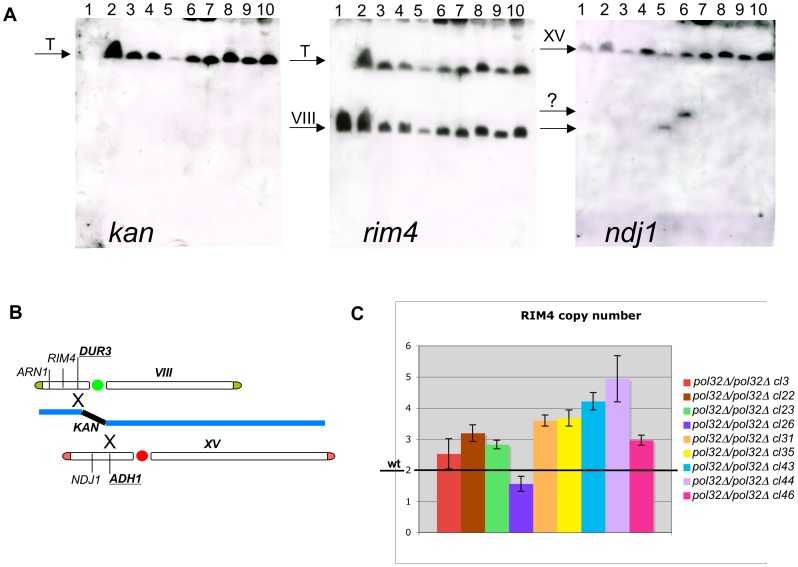
Characterization of nine independent pol32Δ/pol32Δ translocants.A) Southern hybridization of genomic DNA from all the pol32Δ/pol32Δ translocants with probes against kanamycin, rim4 (chromosome VIII) and ndj1 (chromosome XV) loci are shown. Lane 1:wild type San1, 2: pol32Δ/pol32Δcl3, 3: pol32Δ/pol32Δcl22, 4: pol32Δ/pol32Δcl23, 5: pol32Δ/pol32Δcl26, 6 pol32Δ/pol32Δcl31, 7: pol32Δ/pol32Δcl35, 8 pol32Δ/pol32Δcl43, 9 pol32Δ/pol32Δcl44, 10: pol32Δ/pol32Δcl46. T indicates the band of the translocated chromosome. The question mark indicates unknown bands coming from a rearrangement of the left part of chromosome XV on the membrane hybridized with ndj1 B) Scheme of the location of the probes used with respect to the breakpoints (underlined) C) The RIM4 copy number is reported with its own legend on the right. The results are referred to the wild type (here represented by a line with a value of two); each bar is the result of nine independent readings (see Materials & Methods for details).